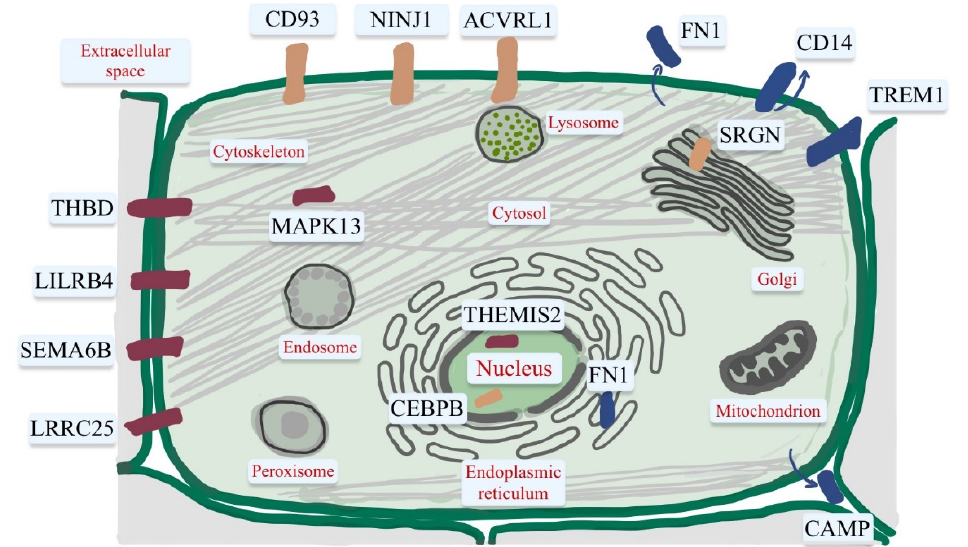
Figure 2. The proteins encoded by the 15 key genes are present at a certain location in the cell. The classification of the proteins is based on their transcriptome profile: orange—genes that encode proteins related to autoimmunity; purple—genes that encode proteins with a general function in infection; blue—proteins that are involved in acute response to infection.